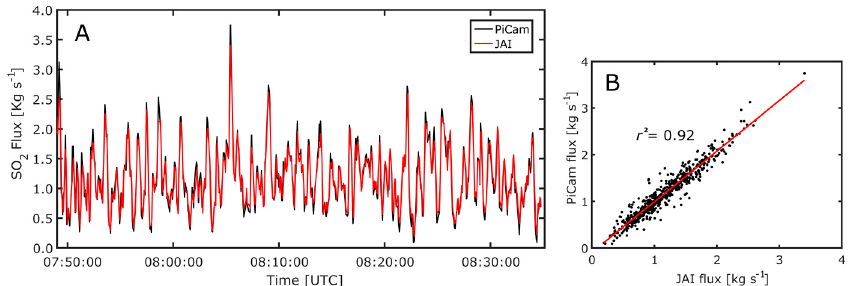
Figure 3. ( A ) Time synchronised SO 2 fluxes calculated from the PiCam (black) and JAI (red) camera systems, between 07:49:00 and 08:35:08 UTC on 19 July 2016. The PiCam retrieved fluxes show excellent concordance with those of the JAI; ( B ) A scatter plot of contemporaneous fluxes, highlighting the remarkable correlation ( r 2 = 0 . 92).